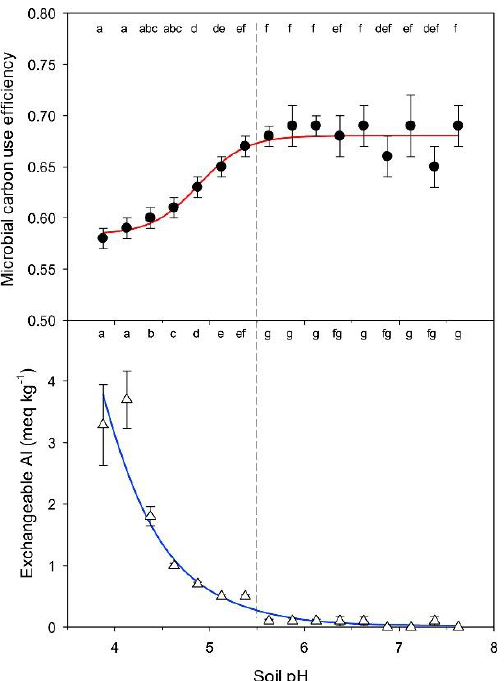
Figure 4. Relationship between soil pH and microbial carbon use efficiency (upper panel) and soil pH and exchangeable Al (lower panel). Values represent means ± SEM. Different letters at the top of each panel represent significant differences between soil pH categories at the p < 0.05 level. The average number of values in each pH category is 68. The dotted line represents the soil pH value point at which there is a transition in the response of both CUE and exchangeable Al. Reprinted with permission from Ref. [98]. Copyright 2019